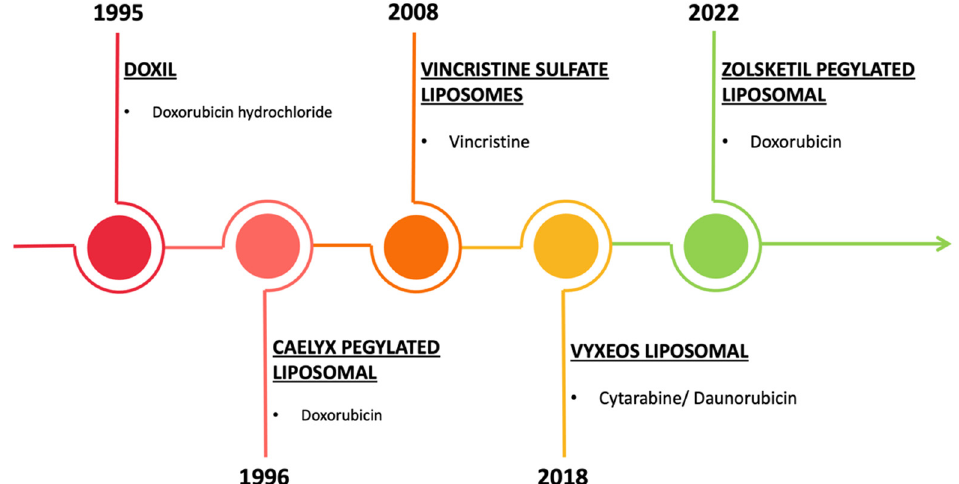
Figure 9. EMA’s approved NP-based drugs. Illustrative representation of the NP-based drugs approved by the EMA to date.